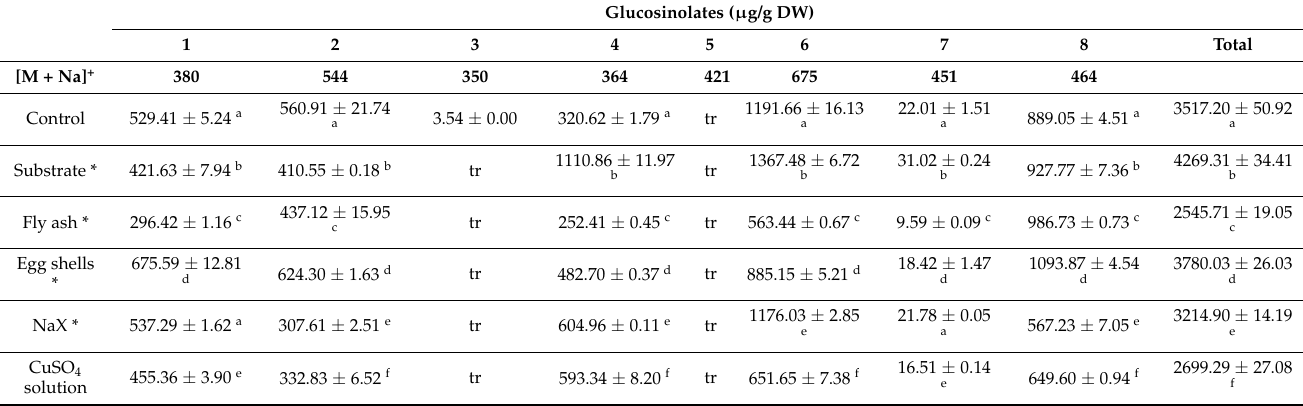
Figure 2. Structures of the glucosinolates identified in the rocket: 1 — 4-(methylsulfinyl)butyl GSL (glucoraphanin); 2 — 4-( β - D -glucopyranosyldisulfanyl)butyl GSL (diglucothiobeinin); 3 — 3-(methylsulfanyl)propyl GSL (glucoibervirin); 4 — 4-(methylsulfanyl)butyl GSL (glucoerucin); 5 — 4-methoxyindol-3-ylmethyl GSL (4-methoxyglucobrassicin); 6 — dimeric 4-mercaptobutyl GSL; 7 — 1,4-dimethoxyindol-3-ylmethyl GSL (1,4-dimethoxyglucobrassicin); 8 — 10-(methylsulfinyl)decyl GSL (glucocamelinin). Chromatograms were given in Figure S1. Table 2. Heavy metal content in the cultivated rocket (whole plant). Table 3. Glucosinolate content in the cultivated rocket (whole plant). Glucosinolates ( µ g/g